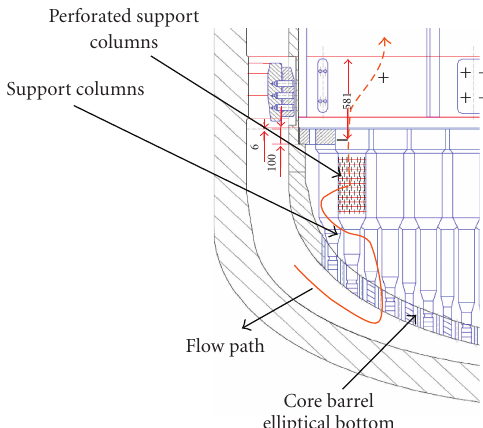
Figure 3: Constructive details of the lower plenum and complex flow path.